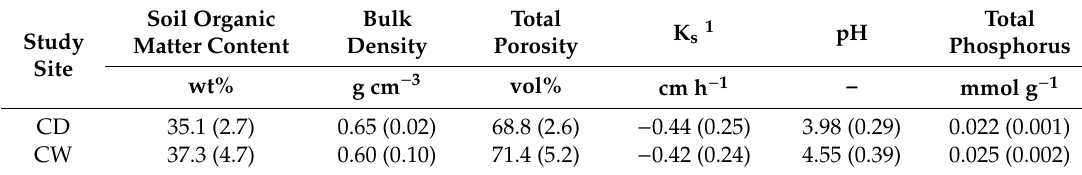
Figure 1. Two adjacent coastal wetlands, coastal drained (CD, with dike), and coastal rewetted (CW, dike removed). Table 1. Physical and chemical properties of the investigated peat soils given as mean (standard deviation), n =